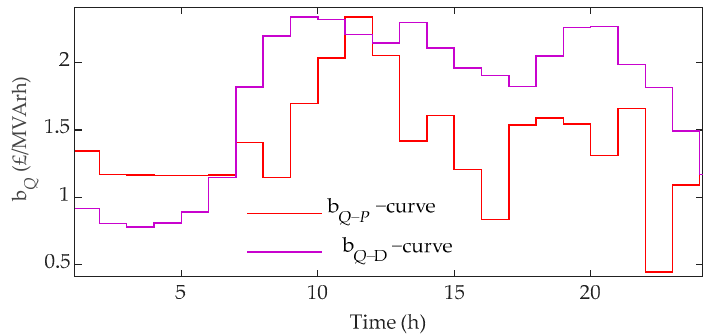
Figure 9. Reactive power price curve based on b P -curve (b Q − P -curve) and reactive power curve price base on the demand curve (b Q − D -curve).